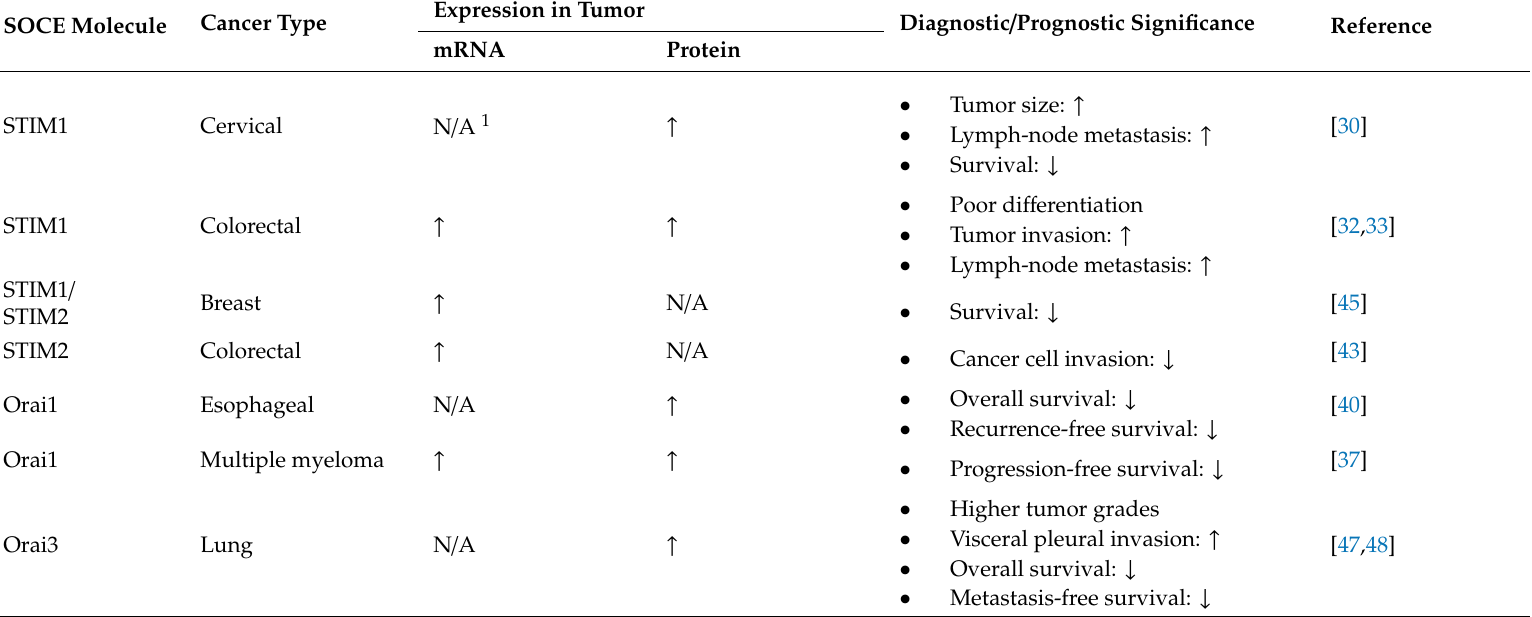
Table 1. Summary of the diagnostic and prognostic values of STIM / Orai in human